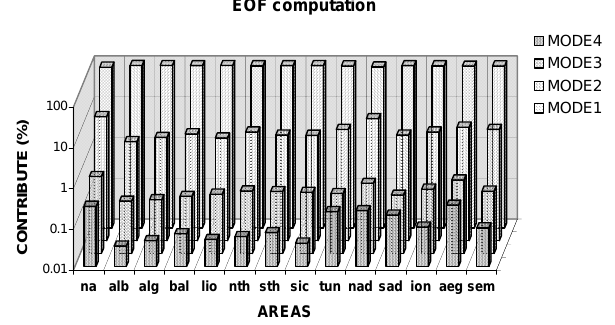
Fig. 11. Contributes of the first four eigenfunctions for each area (y-axis is logarithmic).